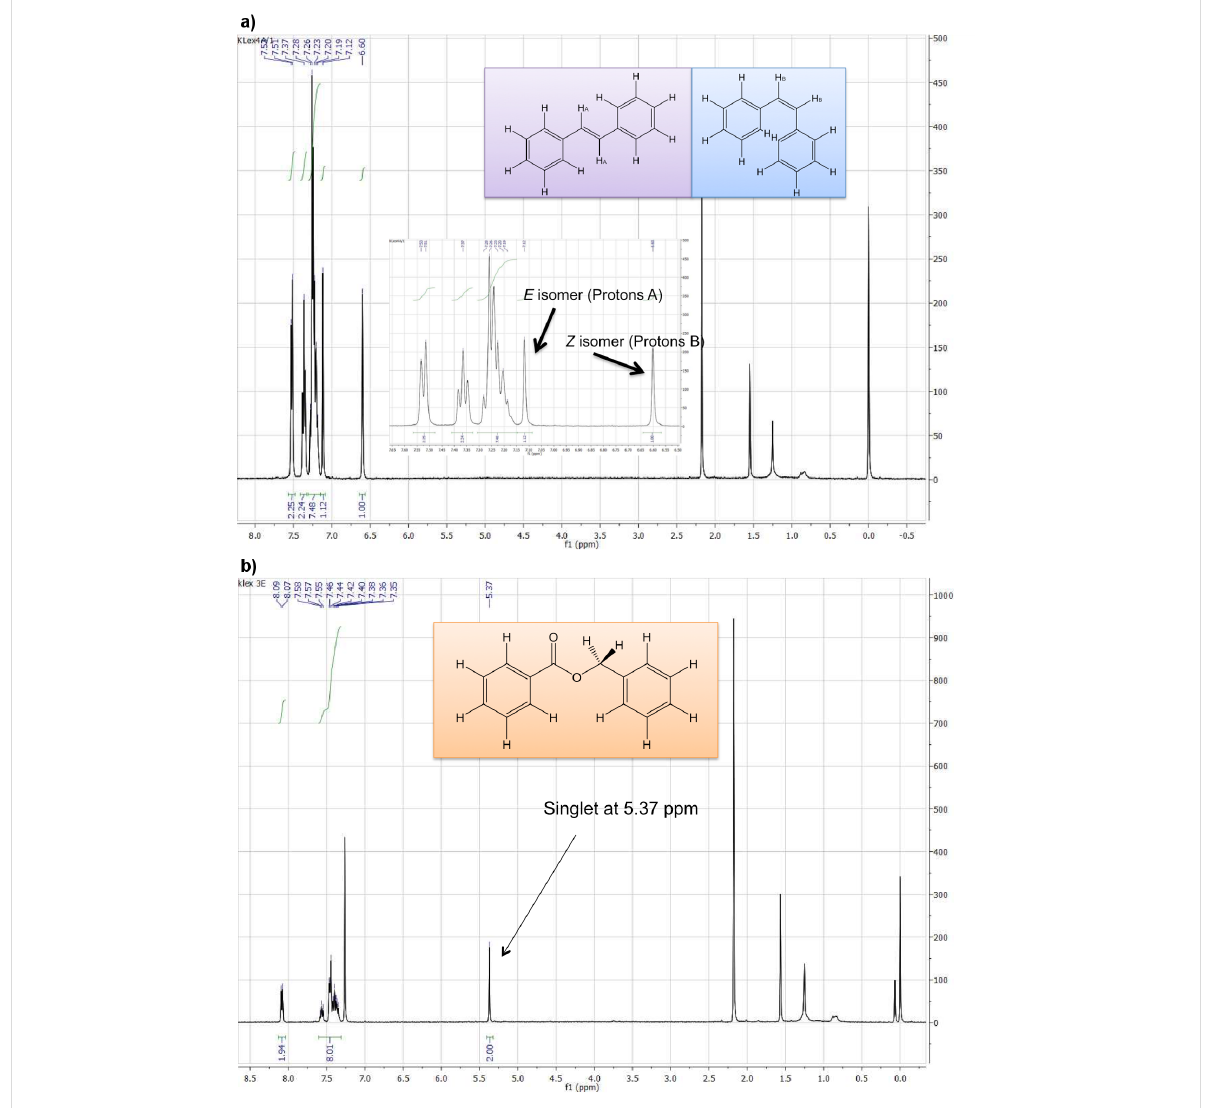
Figure 2: 1 H NMR spectra of stilbene mixture (a) and benzyl benzoate (b).